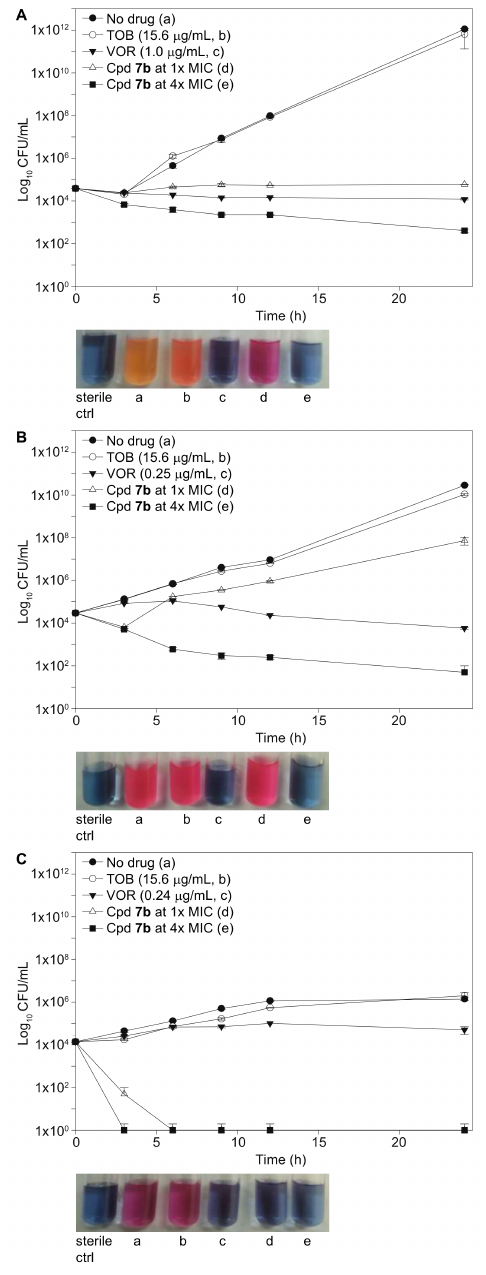
Figure 3. The representative time-kill studies of TOB derivative 7b against ( A ) C. albicans ATCC 10231 (strain A ), ( B ) C. parapsilosis ATCC 22019 (strain J ), and ( C ) Cryptococcus neoformans clinical isolate CN1 . In all panels, the cultures were exposed to a no drug control (black circle), TOB at 15.6 µ g/mL (white circle), VOR at 1.0 or 0.25 µ g/mL (black inverted triangle), and 7b at 1 × MIC (white triangle) and 4 × MIC (black square). Each test tube represents the corresponding sample treated with resazurin, which was added for the visualization of fungal growth. Note: Blue = no fungal growth; orange-pink = fungal